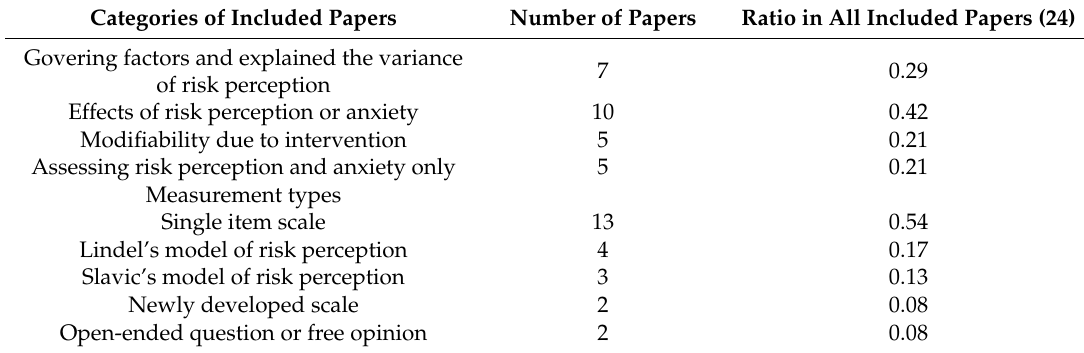
Table 1. Distribution of categories and measurement type used in the included